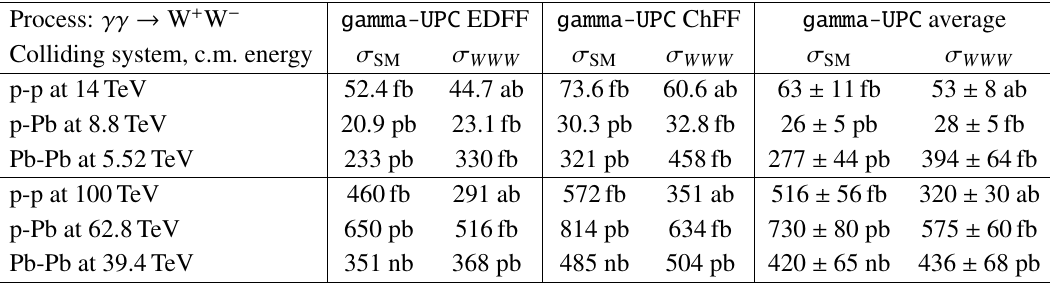
Table 7 . Total SM cross sections, and QGC (cid:27) WWW contributions, for (cid:13)(cid:13) ! W + W (cid:0) in UPCs at the LHC and the FCC-hh, computed with EDFF and ChFF (cid:13) fluxes and their average.